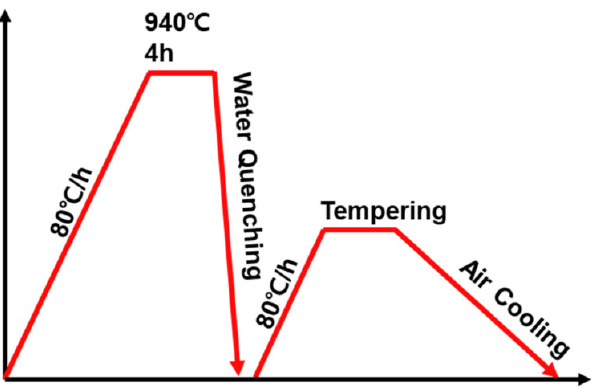
Figure 1. Schematic illustration of post-heat treatment process.